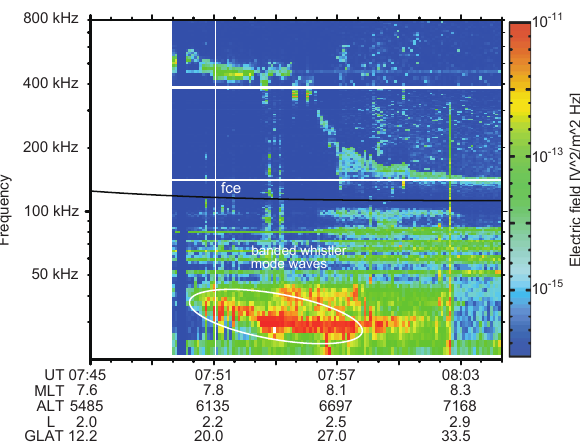
Fig. 6. Local time dependence of the superposed wave electric field amplitude in the frequency range from 25 to 33kHz during the pe- riod from 1992 to 1994. The selected storms are 37 small and mod- erate ones. The zero epoch is taken to be the minimum D st